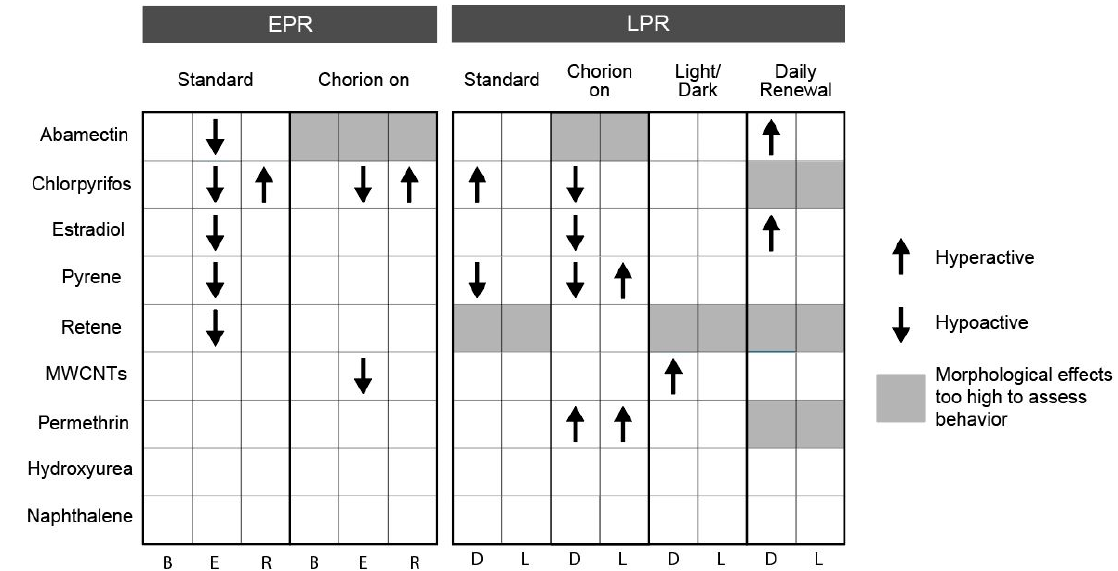
Figure 4. Behavior response associated with exposure to each chemical x condition combination. Combinations with at least two consecutive concentrations associated with significant hyper- or hypo-activity are indicated. Arrows indicate the direction of activity compared to vehicle control for each chemical under each condition. EPR—embryonic photomotor response; LPR—larval photomotor response; B—background; E—excitatory; R—refractory; D—dark;